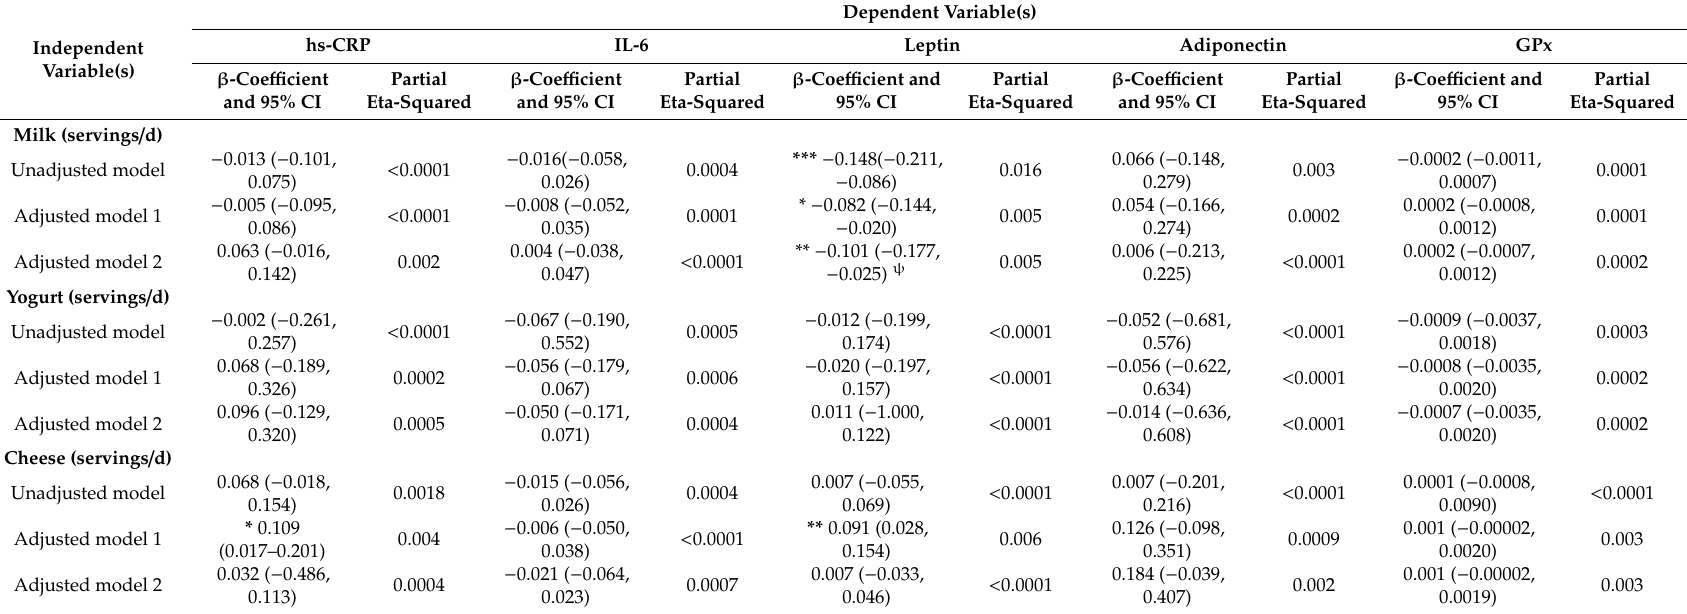
Table 3. Associations between milk, yogurt, cheese consumption, and markers of inflammation, adipocytokines, and oxidative